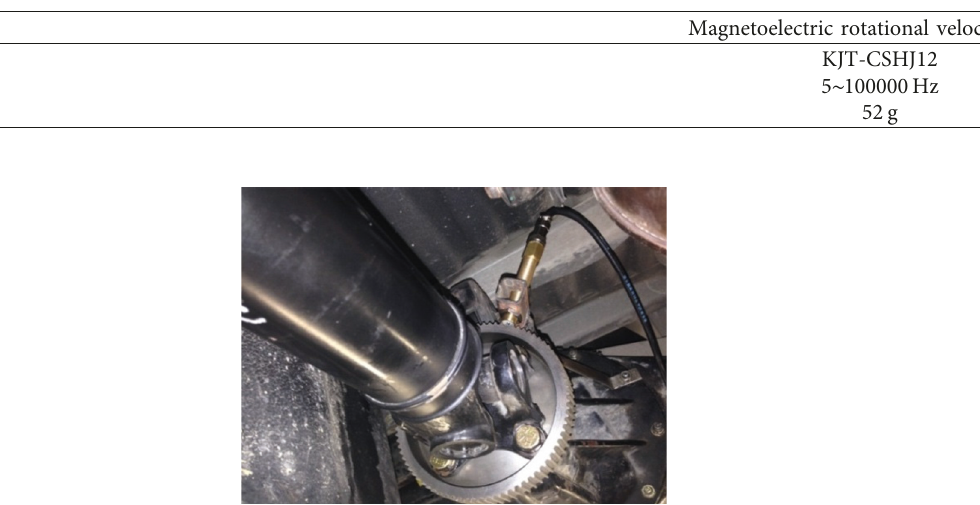
Table 7: Sensors used in drivetrain torsional vibration test.